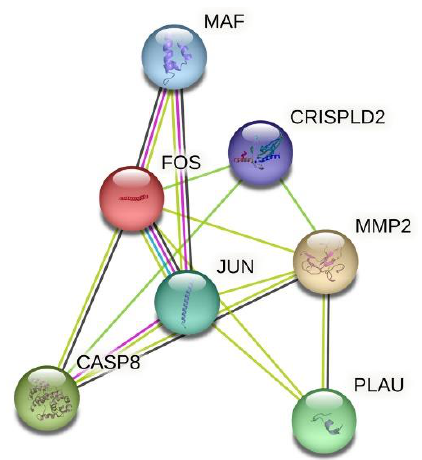
Figure 2. Protein-protein interaction network of the examined genes. A clear node involving FOS, CASP8, MMP2 and CRISPLD2 was generated using STRING. Different colors represent different levels of evidence of connection between proteins. Light blue represents curated databases, purple experimental evidence, light green evidence from text mining and black co-expression. This analysis had an average confidence score of 0.719, suggesting a low rate of false-positive interactions. Supplementary Materials: The following supporting information can be downloaded at: https: //www.mdpi.com/article/10.3390/dj11010007/s1, Table S1. Association between FOS rs1046117 and the risk of nonsyndromic cleft lip with or without cleft palate (NSCL ± P), nonsyndromic cleft lip only (NSCLO) and nonsyndromic cleft lip and palate (NSCLP) in patients stratified by genomic ancestry: high European (A) and high African (B). p values were adjusted for covariates by logistic regression analysis. Table S2. Association between CASP8 rs3769825 and the risk of nonsyndromic cleft lip with or without cleft palate (NSCL ± P), nonsyndromic cleft lip only (NSCLO) and nonsyndromic cleft lip and palate (NSCLP) in patients stratified by genomic ancestry: high European (A) and high African (B). p values were adjusted for covariates by logistic regression analysis. Table S3. Association between MMP2 rs243836 and the risk of nonsyndromic cleft lip with or without cleft palate (NSCL ± P), nonsyndromic cleft lip only (NSCLO) and nonsyndromic cleft lip and palate (NSCLP) in patients stratified by genomic ancestry: high European (A) and high African (B). p values were adjusted for covariates by logistic regression